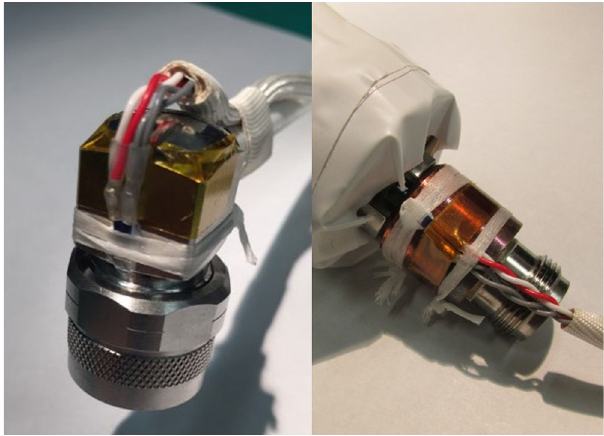
FIG. 2. Temperature sensors installed on the cable end (left, 90° connector) and cavity HOM feedthroughs